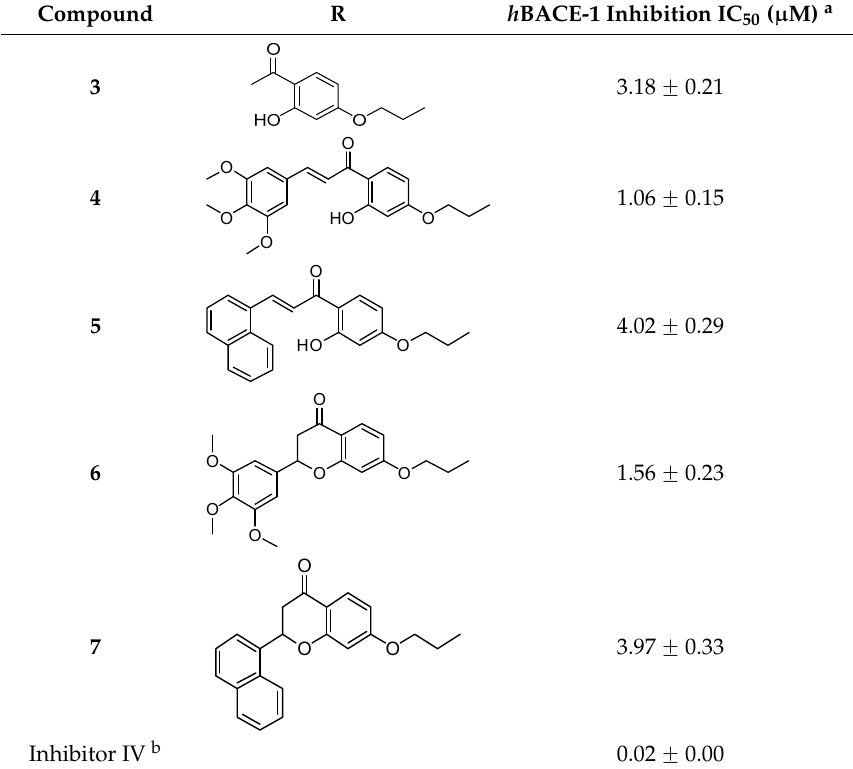
Table 1. BACE-1 inhibitory potency of the new compounds 3 – 7 and reference compound (inhibitor IV). Compound